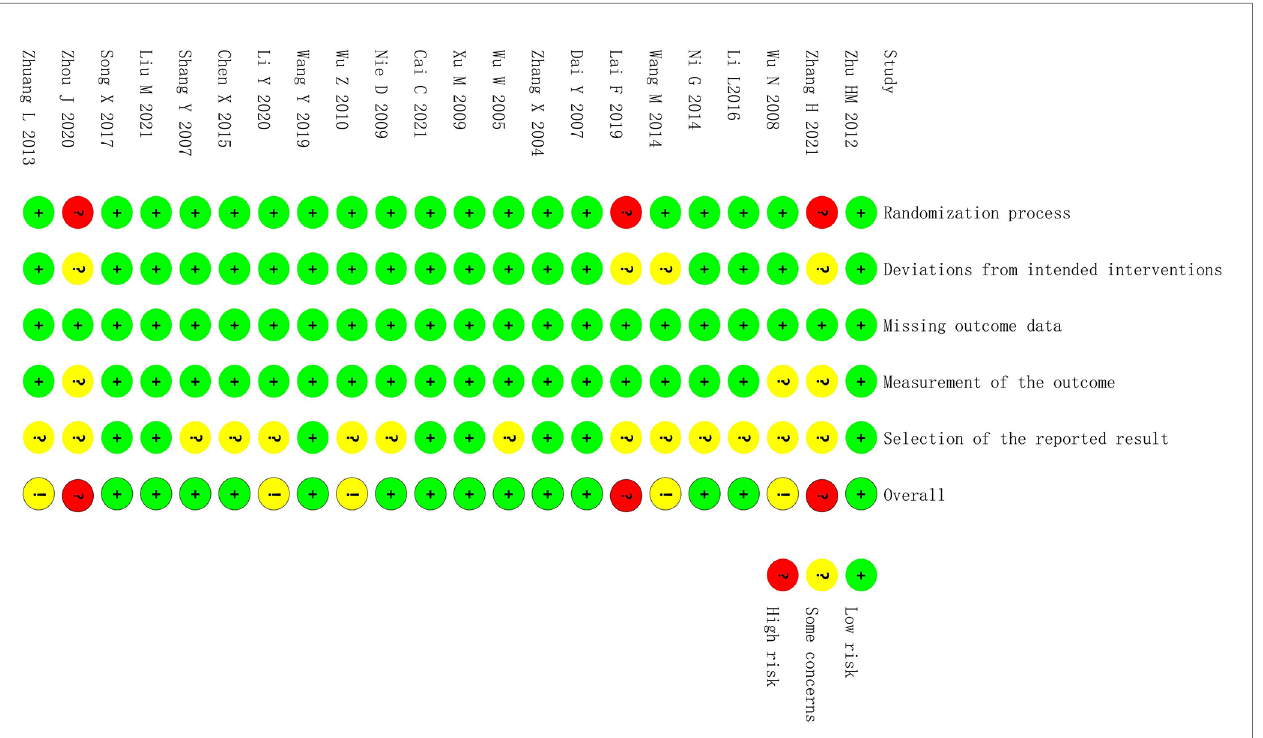
FIGURE 2 | Risk of